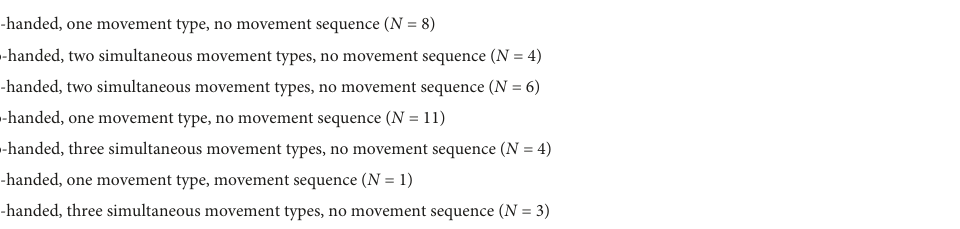
TABLE 2 Accuracy in signs that vary by number of hands and movement combinations (simultaneous and sequential). Pseudosign complexity (number of hands * number of simultaneous movement types * number of movement sequence)